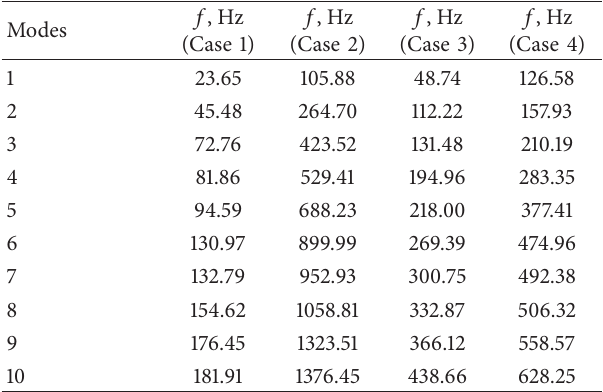
Table 3: Flight test conditions and air properties. Table 4: First 10 natural frequencies for the composite